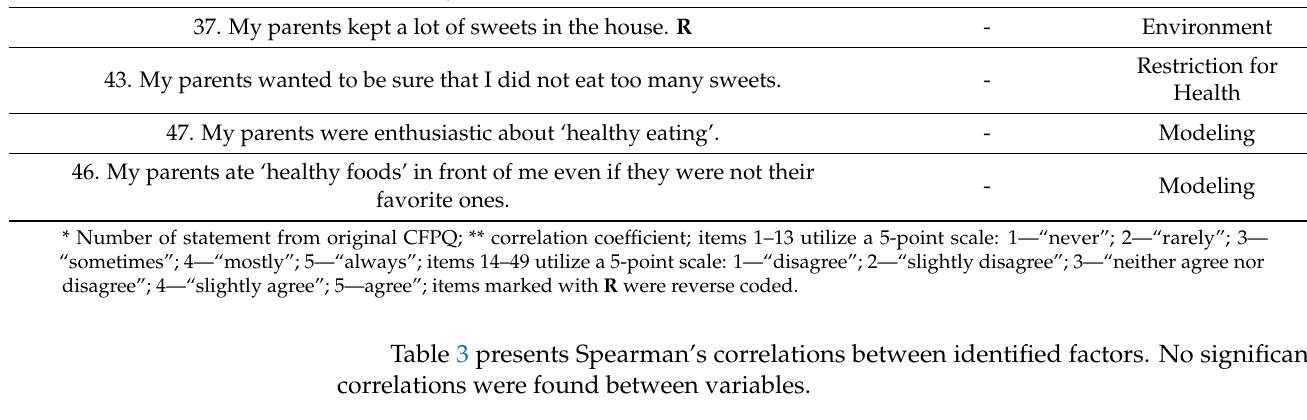
Table 3. Spearman’s correlations (rho) between identified